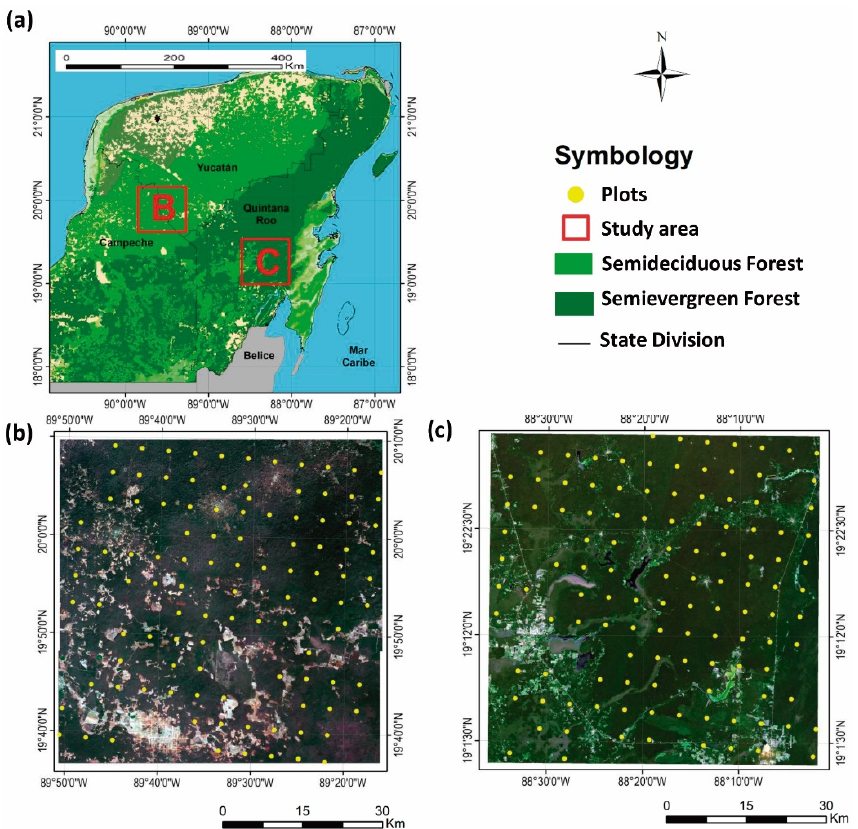
Figure 1. Location of the two study sites in the Yucatan peninsula ( a ). Distribution of the National Forest Inventory field plots in the tropical semi-deciduous forest ( b ) and the tropical semi-evergreen forest ( c ).